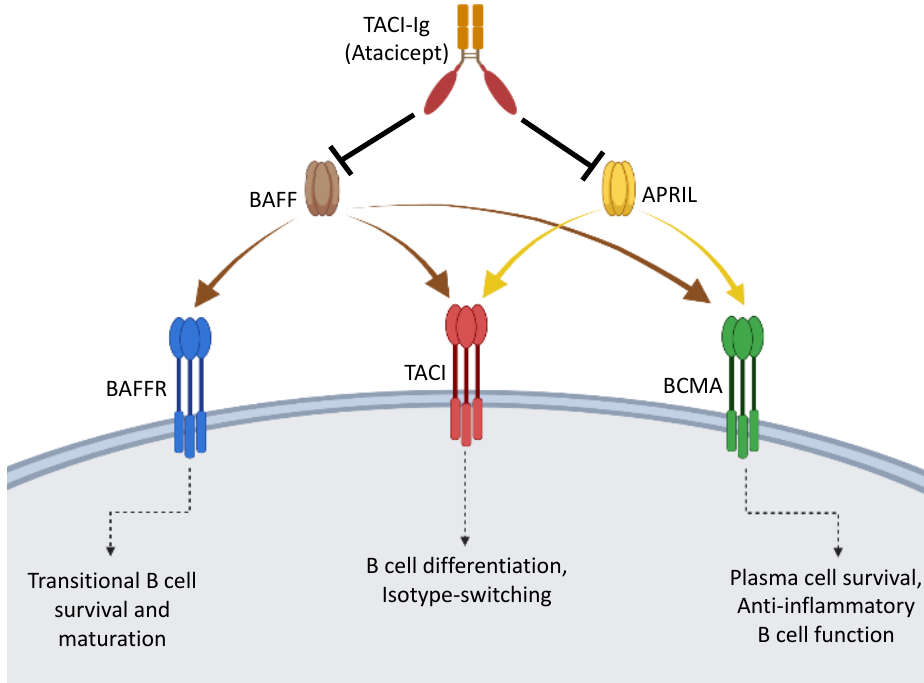
Figure 1. B cell activating factor (BAFF) and a proliferation-inducing ligand (APRIL) are cytokines that bind to BAFF receptor (BAFFR), transmembrane activator and calcium modulator and cyclophilin ligand interactor (TACI), and B cell maturation antigen (BCMA) expressed on the surface of B cell subsets. BAFF and APRIL signal through the receptors to affect B cell subset development, survival, and function. Recombinant TACI-Ig (atacicept) inhibits BAFF and APRIL function by blocking binding to their receptors.